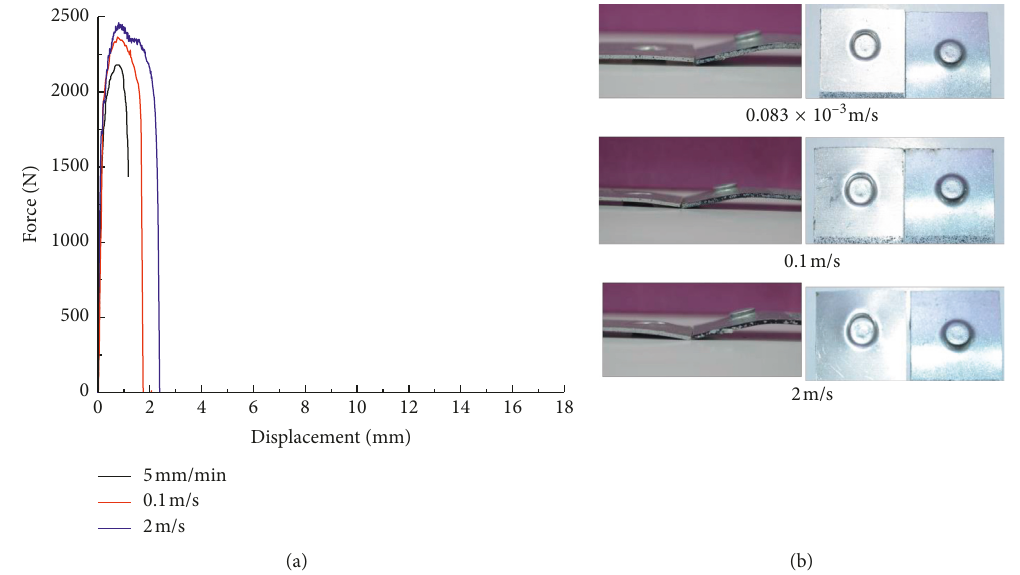
Figure 8: Dynamic lap-shear tests of clinched joints: (a) force-displacement curves and (b) failure modes at three